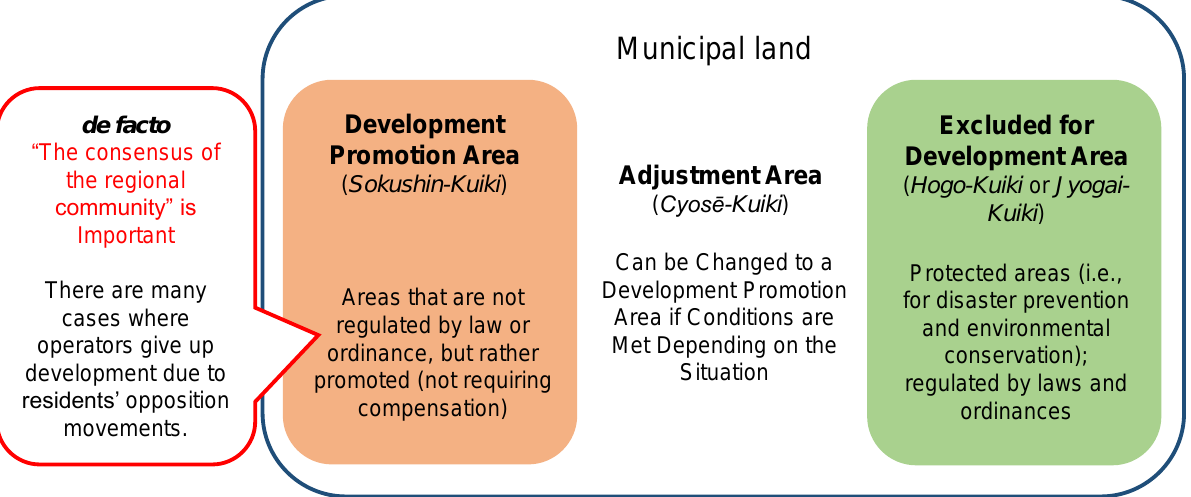
Figure 4. Current status of promoting areas for renewable energy sites in Japan (modified from Kohsaka and Kohyama